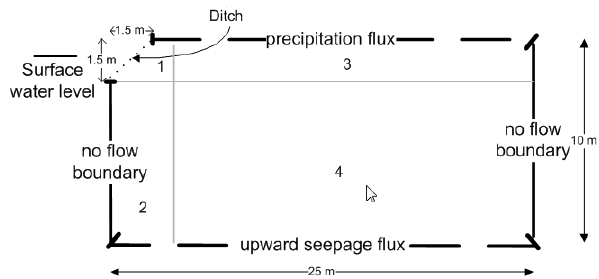
Fig. 2. Sketch of the geometry and boundary conditions for a half field and its drainage area (ditch). The black lines are the domain boundaries. Areas 1 to 4, separated by grey lines, represent different discretisation zones. Length and width are indicated and the ditch has a triangular cross-section and a water level of 1m below soil